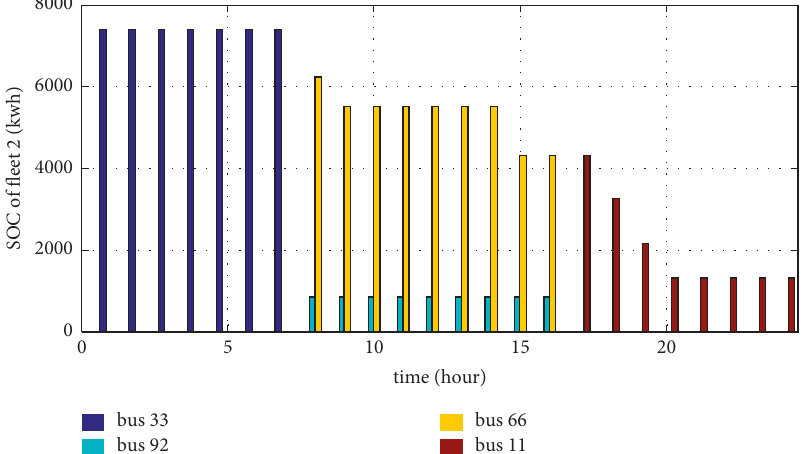
Figure 16: SOC of PEV fleet 2 in case 3 (the first scenario).